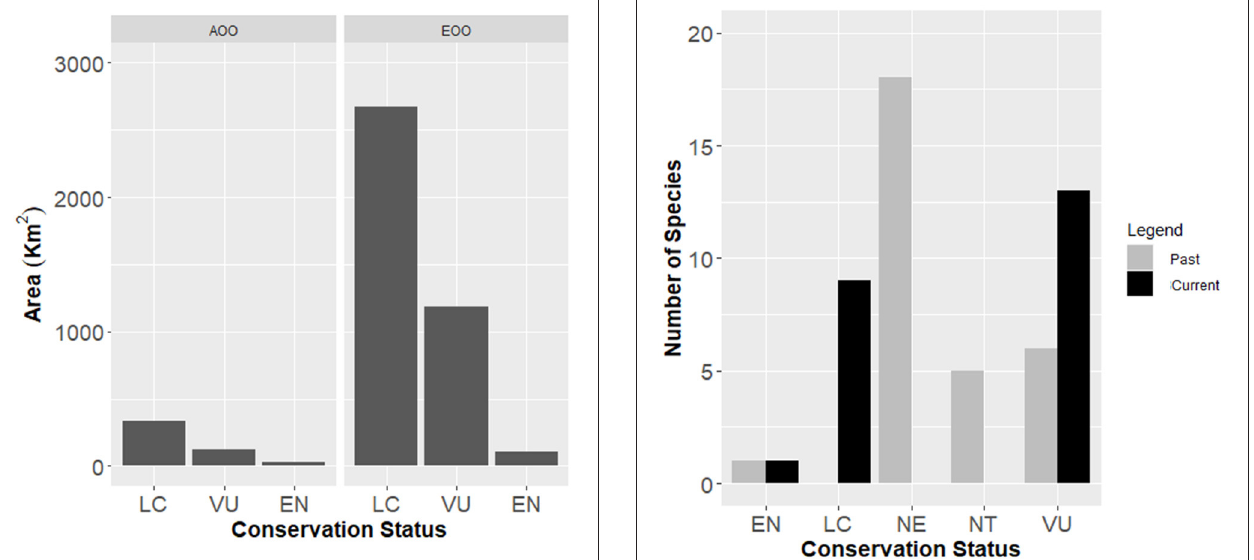
FIGURE 4 | Status change of the Aeonium genus in the IUCN Red List from the previous inventories to the present assessment. IUCN Red List categories: NE, Not Evaluated; LC, Least Concern; NT, Near Threatened; VU, Vulnerable; EN, Endangered. Number of species assessed in each category (total assessments: nine in previous and 23 in the current). All species assessed in assessment are illustrated (see Table 1